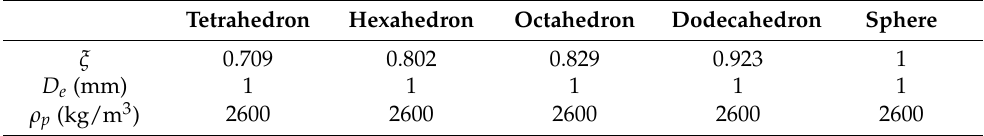
Table 2. Particle